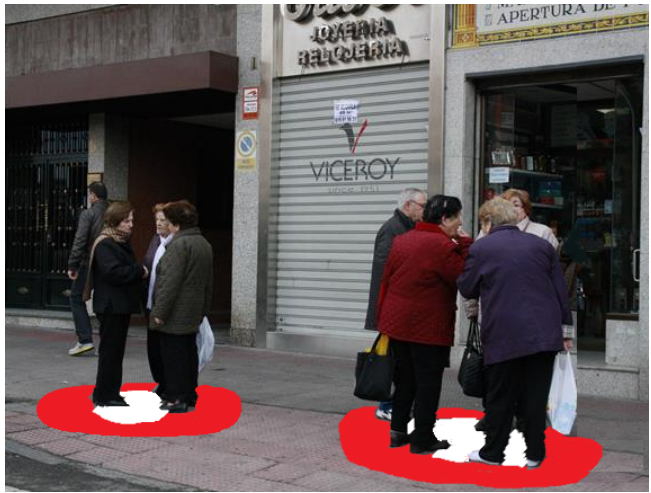
Figure 4. “O” and “P” spaces for groups (white and red,